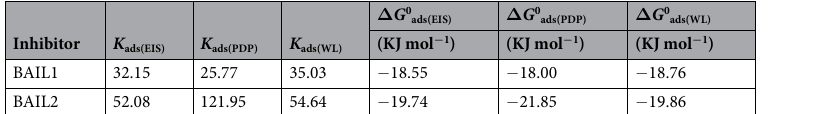
Inhibitor K ads(EIS)